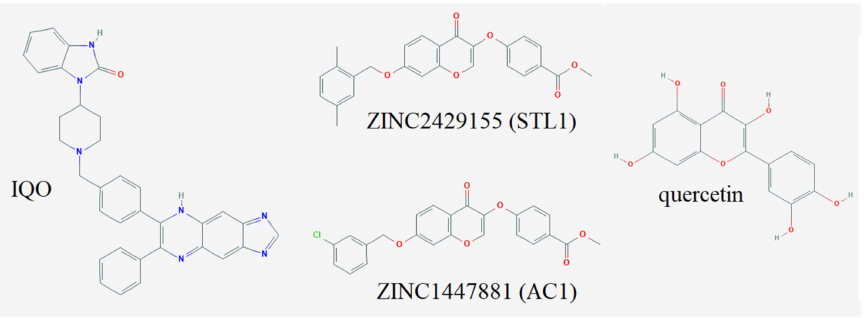
Figure 5. Chemical structures of the compounds investigated in the present